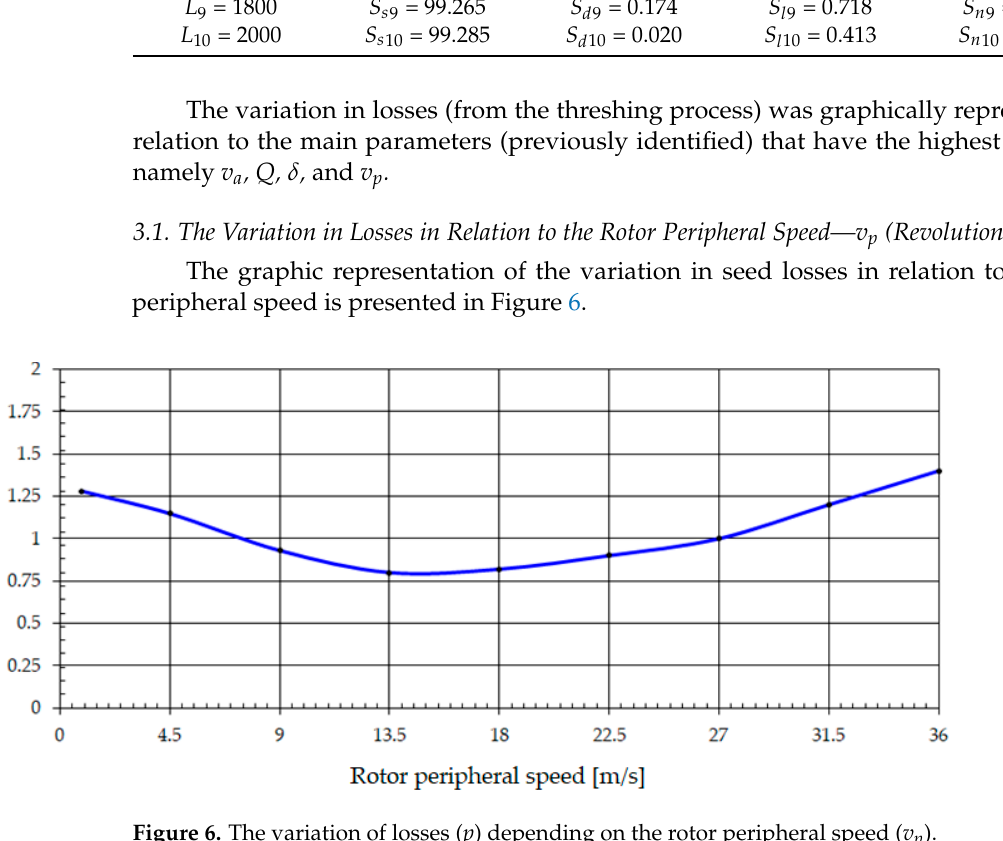
unthreshed seeds along the threshing length of the axial apparatus.